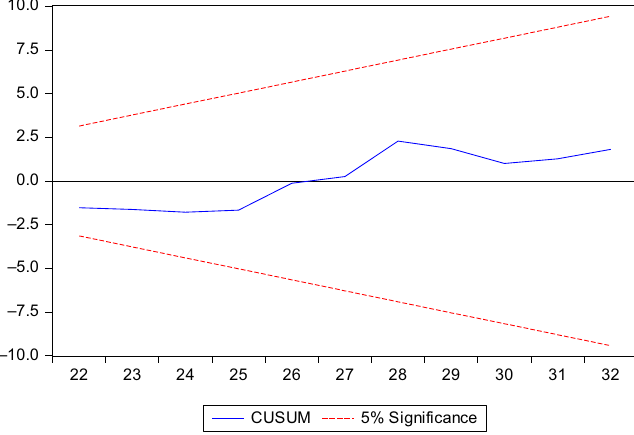
Figure 2. CUSUM test